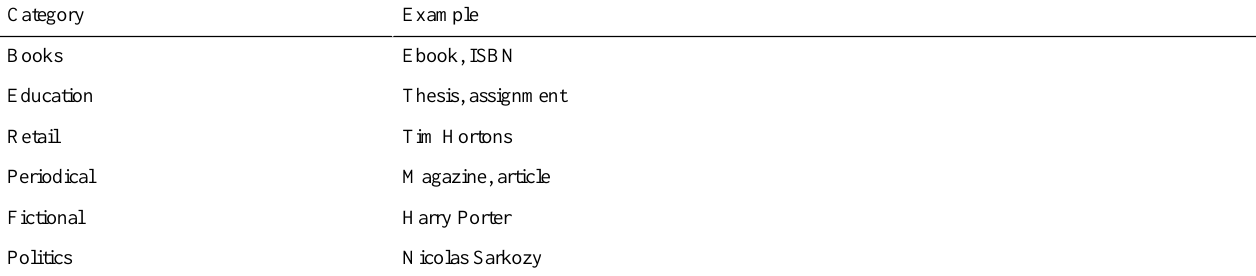
Table 1. Publishable content